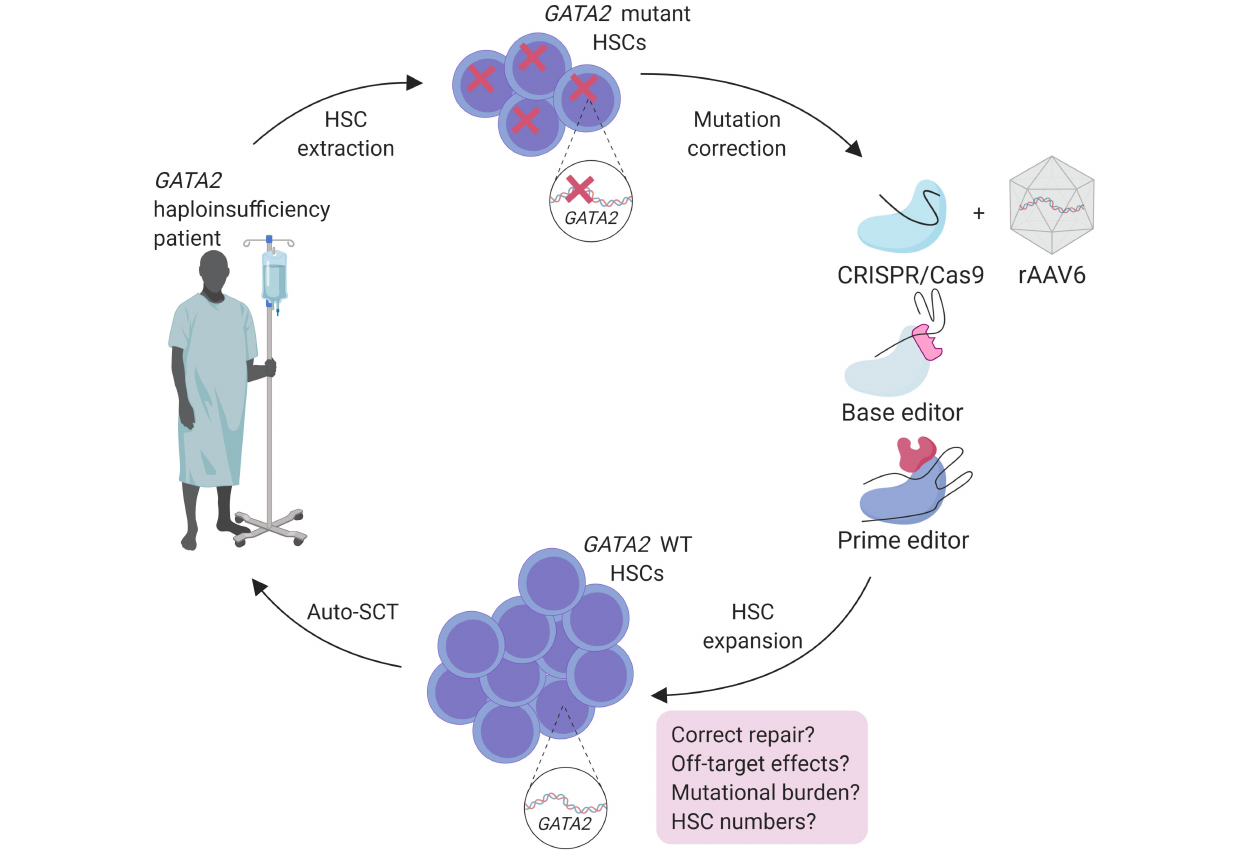
Frontiers in Genome Editing |